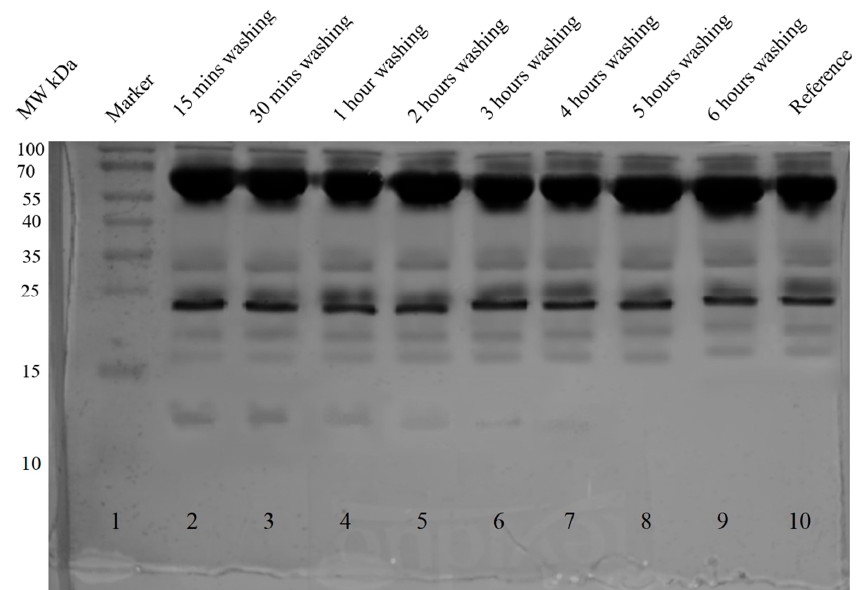
Figure 6. SDS PAGE (15% silver-stained uncropped gel) analysis of the presence of hemoglobin in blood plasma. Lanes 2 to 7 show the presence of hemoglobin in plasma from conjugates. Lanes 8 and 9 show no presence of hemoglobin in plasma from conjugates. Lane 10 is reference blood plasma.